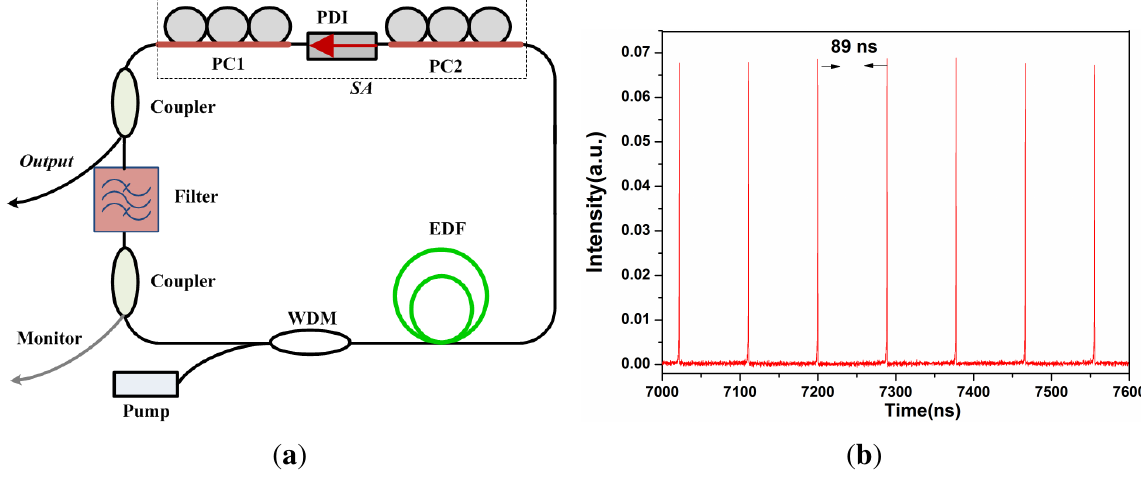
Figure 6. ( a ) Schematic of a filter-based dispersion-managed passively-mode-locked EDF laser. WDM: wavelength-division multiplexer; EDF: erbium-doped fibre; PC: polarisation controller; PDI: polarisation-dependent isolator; SA: saturable absorber. ( b ) Typical output pulse train observed on the